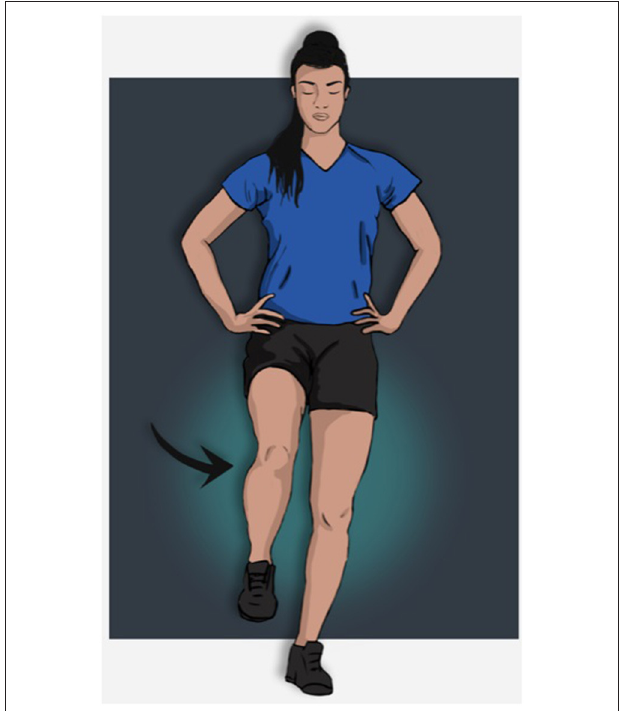
FIGURE 1 | Single leg stance on firm surface or foot lift test of the left limb.